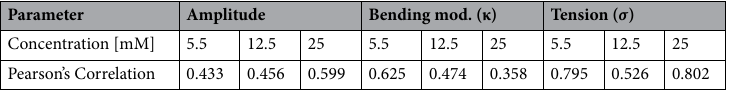
Table 3. Pearson’s correlations for mean mechanical